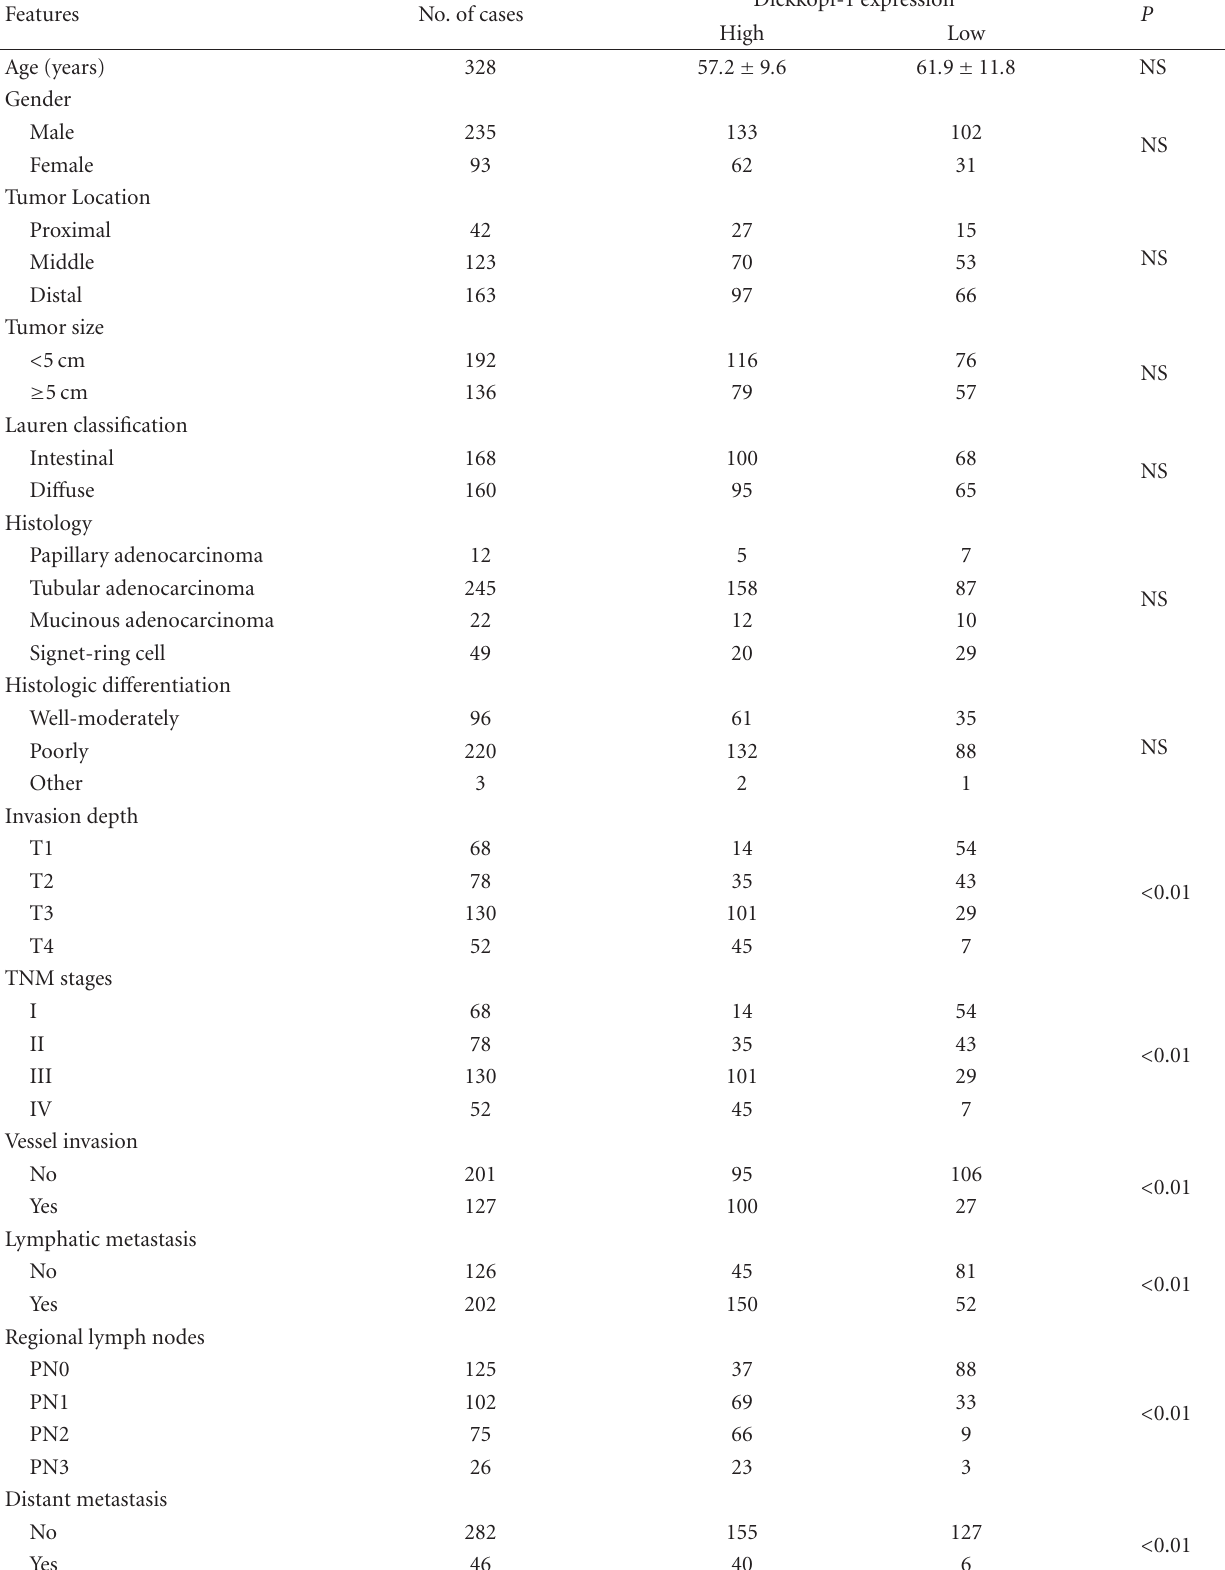
Table 1: Correlations of Dickkopf-1 expression with the clinicopathological features of gastric